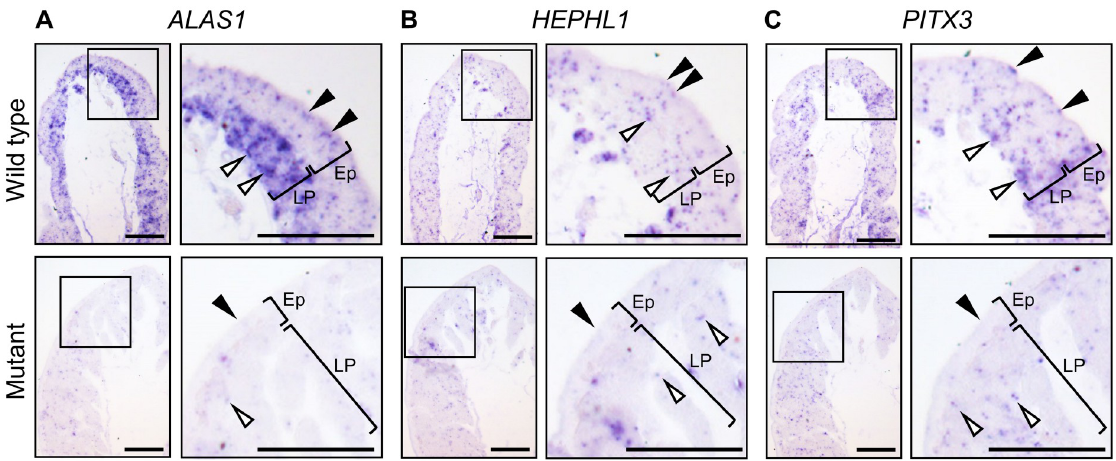
Fig 5. Distribution of PITX3 , ALAS1 , and HEPHL1 transcripts in uterine mucosal tissues. (A–C) Light micrographs of the sections of mucosal folds of the wild-type (upper panels) and mutant (lower panels) uteri. PITX , ALAS1 , and HEPHL1 were expressed in the apical cells on the luminal side of the epithelia (Ep) of the wild-type uteri, and their expression was observed as bluish hybridization signals (upper panels, black arrowheads). Hybridization signals were also observed in the cells of the lamina propria (LP) (upper panels, white arrowheads). ALAS1 was highly expressed in the cells of LP. The hybridization signals of three genes in the luminal side of the Ep (lower panels, black arrowheads) and LP cells (lower panels, white arrowheads) of the mutant were weak compared to those of the wild type.